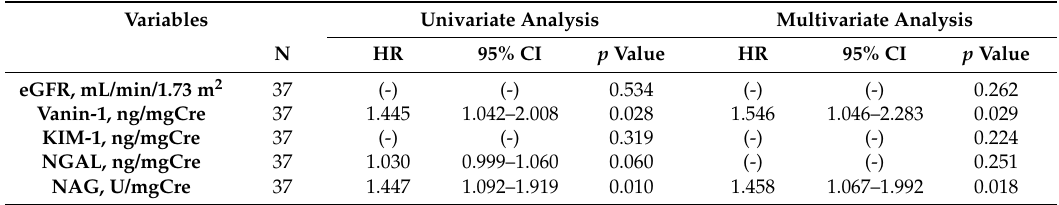
Table 2. Univariate and multivariate analysis to identify the independent factors that predict the presence of hydronephrosis. Variables Univariate Analysis Multivariate